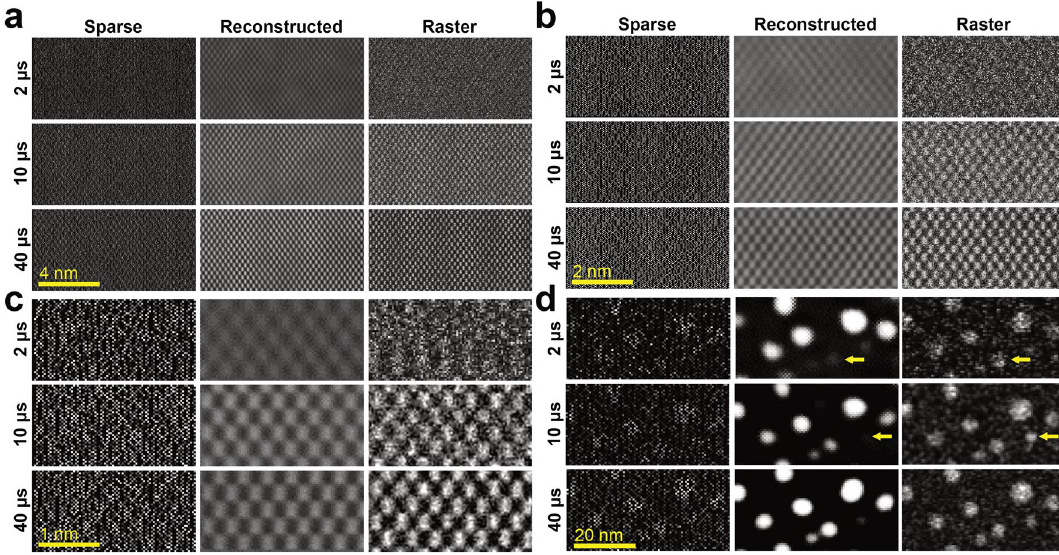
Figure 5. Comparison between reconstructed and experimental STEM images. Atomic resolution images of [110] Si with τ = 400 μs but different T D . The random-walk routine acquires 1/3 of all possible ( a ) 512 × 512, ( b ) 256 × 256 and ( c ) 128 × 128 pixels. The pixel size pxsz = 30.1 pm was kept constant. ( d ) Extract from a 128 × 128 scan routine ( pxsz = 0.77 nm) of the AuNPs at different noise levels in order to promote the appearance of